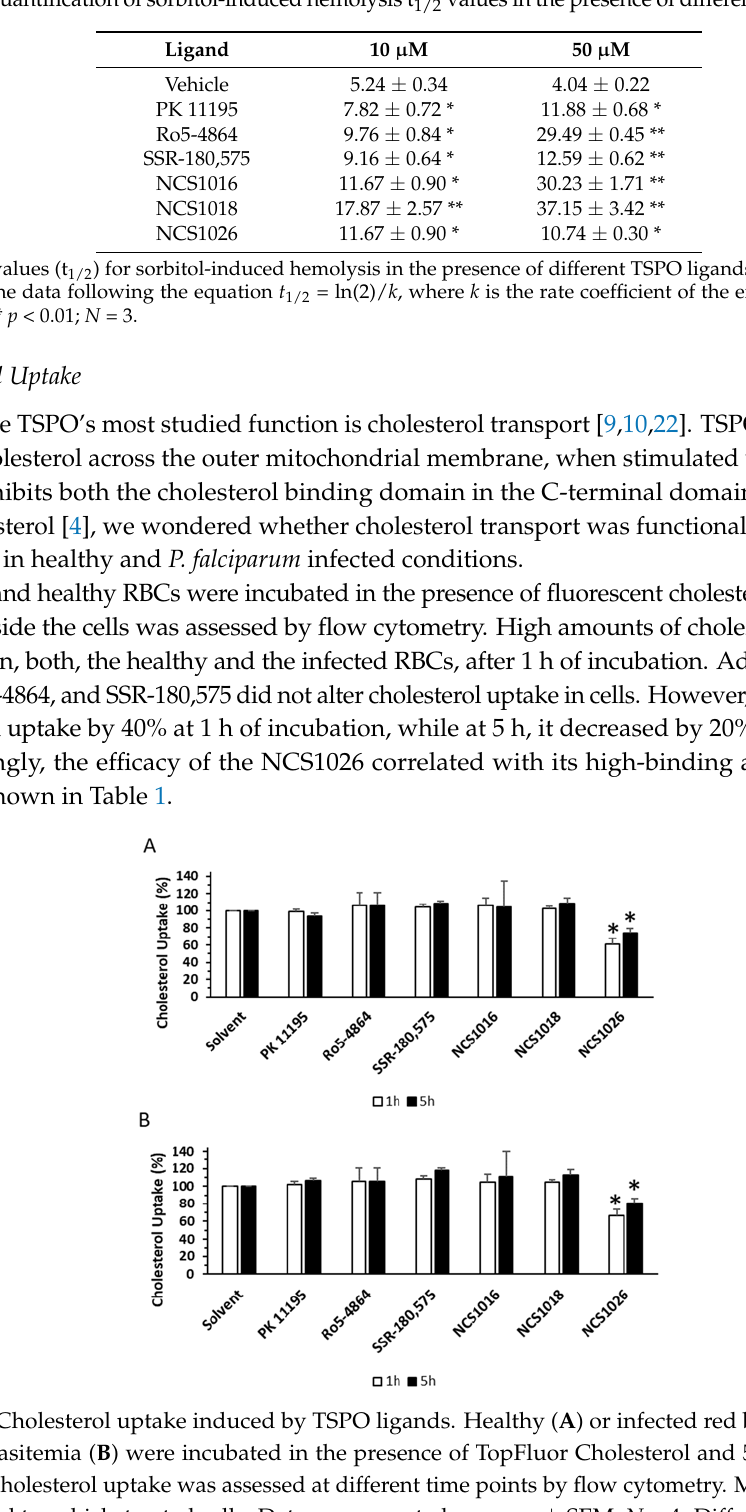
Table 3. Quantification of sorbitol-induced hemolysis t 1/2 values in the presence of different TSPO ligands.